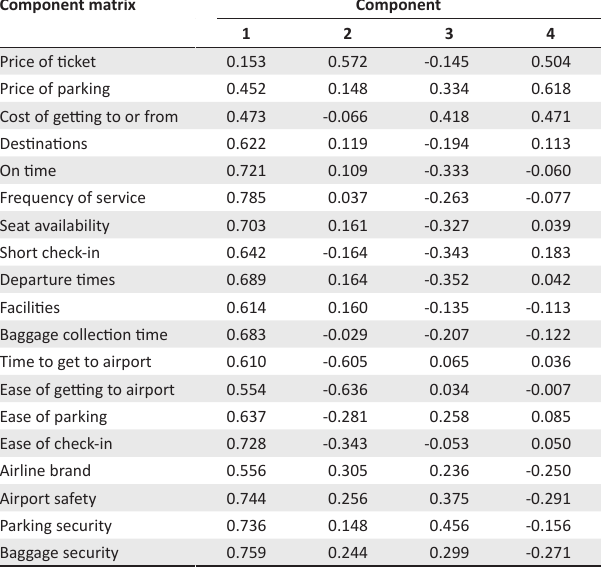
FIGURE 5: Scree plot. TABLE 2: Confirmatory factor analysis – four factors (2013).